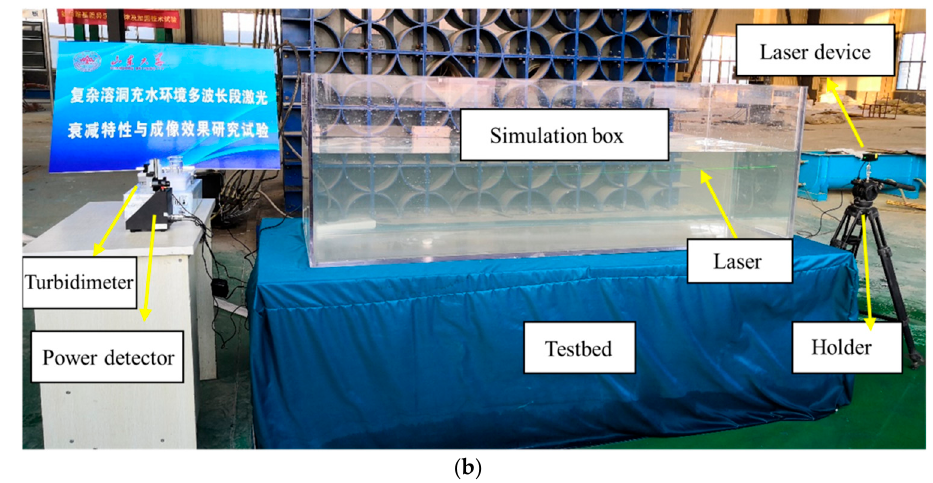
Figure 1. Testing system: ( a ) design; ( b ) actual device graph.